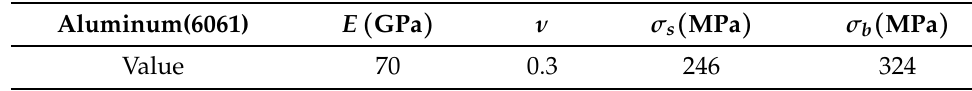
Table 5. Mechanical property of 6061-Al.